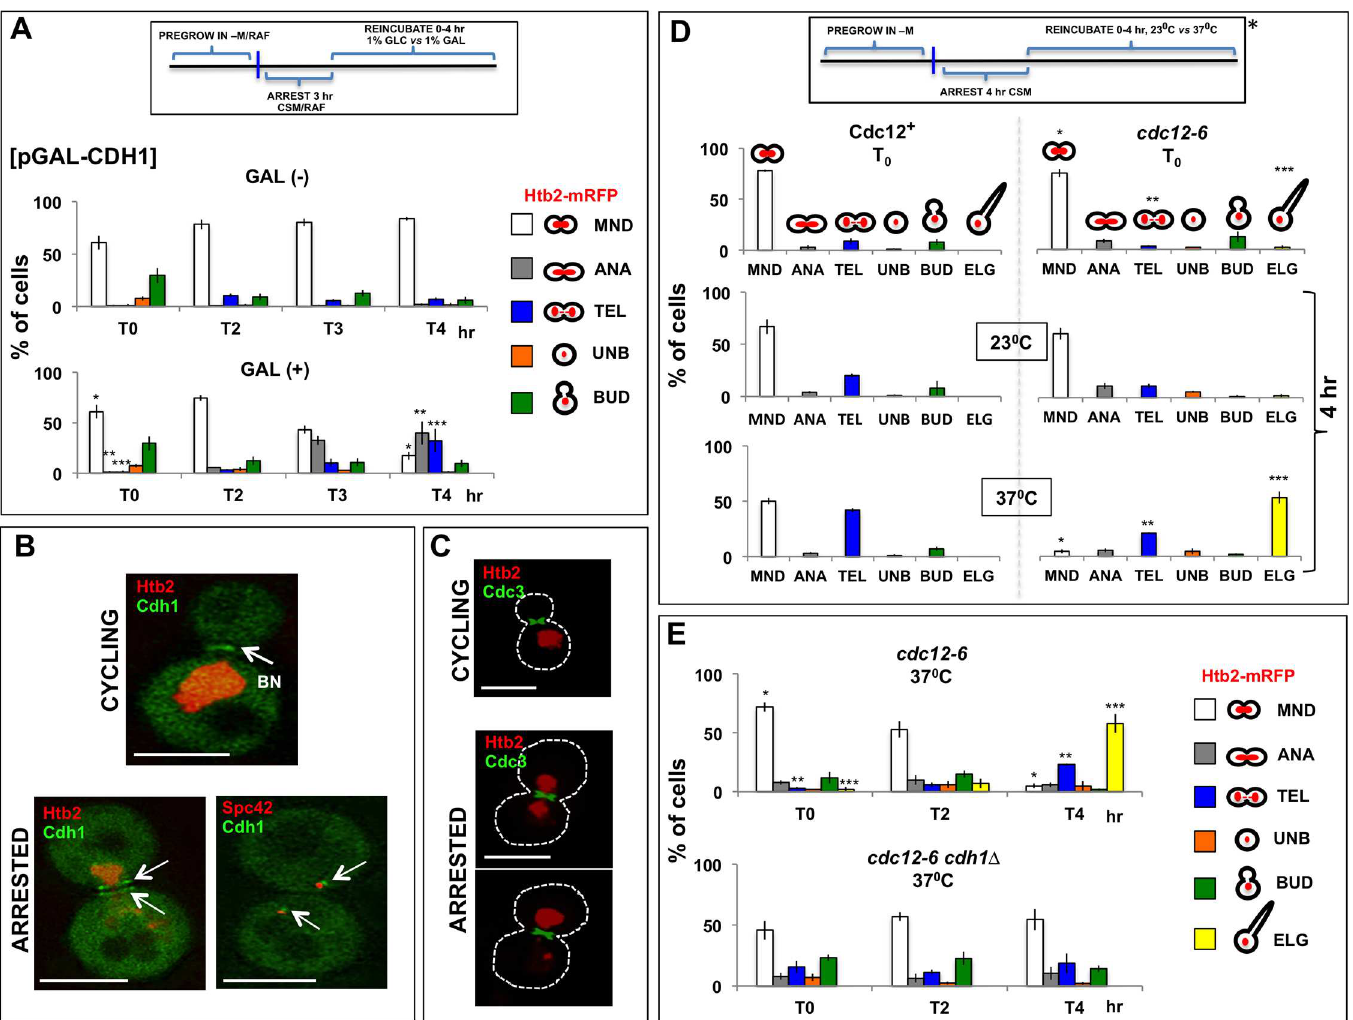
Fig 4. Arrest depends on septin integrity and Cdh1. (A) Inductionof Cdh1 expressionin arrested cells results in escape. A MET3-CDC20 strain expressingHtb2-mRFP and carrying a CEN plasmid for inductionof Cdh1 expressionfrom a GAL1/10 promoterwas arrested for 3 hour in raffinose medium. The cells were then supplemented with 1% galactose(GAL (+)) or 1% glucose(GAL (-)) for 0–4 hours (T0, T2, T3 and T4). By examiningthe distributionof chromatin, as well as overall shape, the cells were classified into the followingcategories: MND (chromatin spans the bud neck), ANA (chromatin has begun to stretch), TEL (chromatin has stretched to form two terminal masses that remain connected). In addition,we tabulatedunbuddedcells (UNB), and cells with small to medium-sizedbuds (BUD). Note that, inductionof Cdh1 expression caused the cell cycle to advance.Statistical significancewas evaluatedby Student’s t -test. In the lower right panel, pairs of bars (before and after galactoseinduction) bearingthe same numberof stars have been comparedto each other. * P < 0.001, ** P < 0.005, and *** P < 0.05. Strain: ATY7545. (B) Localization of Cdh1 in cycling and arrested cells. Cycling cells: In cells expressing Cdh1-GFP and Htb2-mRFP, Cdh1-GFP was detected in the nucleus,the cytoplasm and at the bud side of the bud neck (bud side, arrow). Arrested cells: A MET3-CDC20 strain expressingCdh1-GFP and Htb2-mRFP was arrested for 4 hours and examined.Note that Cdh1-GFP localizedto the cytoplasm and was found at the bud neck (both sides, even when cytokinesishas not occurred, judgingfrom the distributionof Htb2-mRFP) and adjacentto SPBs (arrow). In the bottom image, the Spc42-CFPsignal was pseudocolored in red. Strains: ATY7652 and ATY7710. (C) Septin distribution in arrested cells. A MET3-CDC20 strain expressingHtb2-mRFP and a taggedseptin, GFP-Cdc3, was arrested for 4 hours and imaged.Note that the septin hourglassencircledthe bud neck and that its organizationdid not obviouslychange duringtransits. Strain: ATY3847. (D) Destabilization of arrest in a septin mutant. A MET3-CDC20 strain expressingHtb2-mRFP (left panels) and an equivalent strain that carried the cdc12-6 ts septin mutation (right panels) were arrested at 23˚C for 4 hours. The cells were then further incubatedat 23˚C or at 37˚C for 0, 2, or 4 hours and examined.They were assignedto categoriesas above. An additionalcategory (ELG) is for single cells with an elongated bud. Note that the cell cycle advancedin the ts mutant strain to the point that almost no MND cells remained, with parallelaccumulationof cells with elongatedbuds. Arrest remainedstable in the Ts+ cells. Statistical significancewas evaluatedby Student’s t -test. In the top right and bottom right panels, pairs of bars (i.e. before septin inactivation vs after inactivation) bearingthe same numberof stars have been comparedto